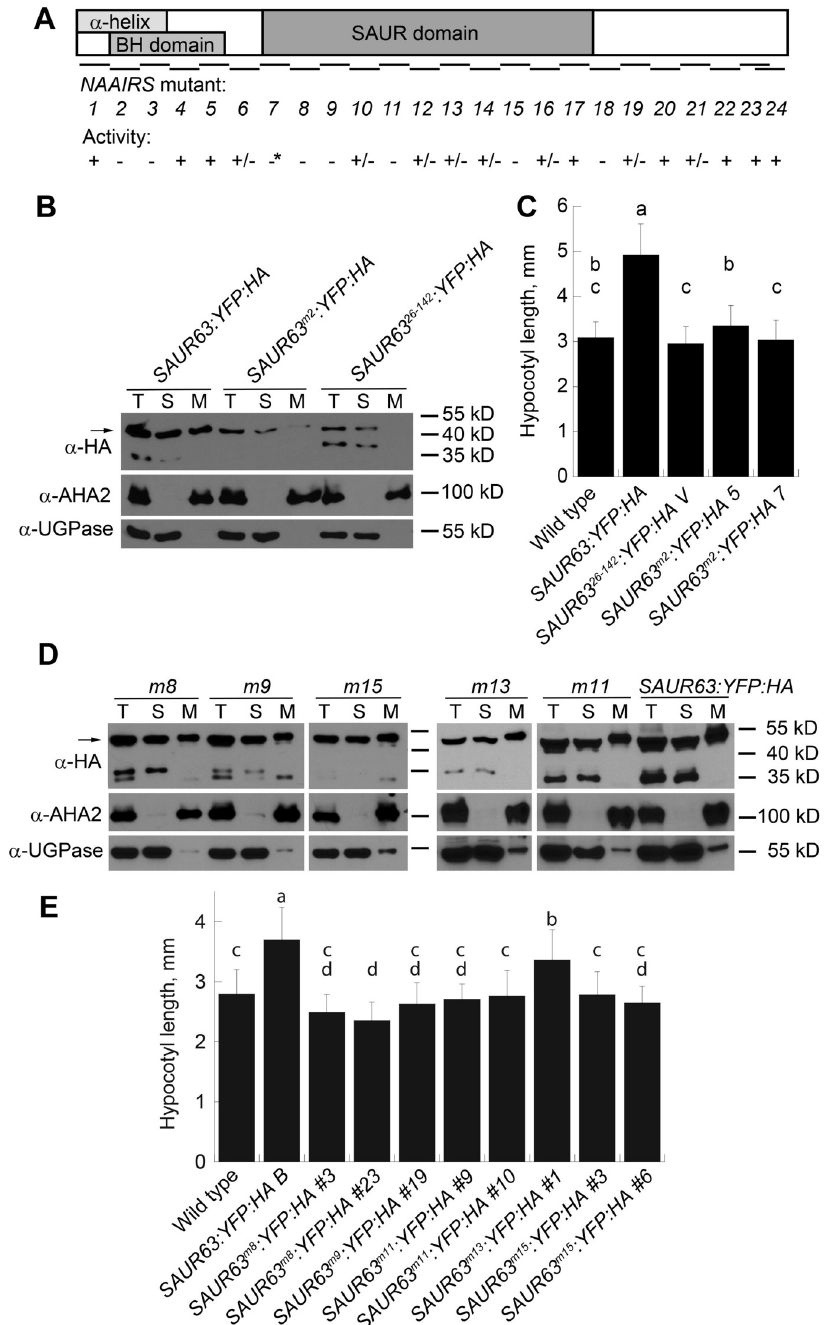
Fig 7. Effects of mutations on SAUR63 properties. A) Diagram of SAUR63 indicating predicted structural features, locations of NAAIRS mutations m1 - m24 , and whether SAUR63:CerFP:HA and/or SAUR63YFP:HA fusion proteins with each mutation retained function, based on their ability to confer either tortuous root growth or increased hypocotyl elongation in Figs 7C and 7E and S11 and S1 Table. +, caused phenotypes in all experiments; -, failed to cause phenotypes in all experiments; +/- caused phenotypes in at least one experiment; � , no fusion protein detected. B,D) Fusion proteins in stable P : SAUR63 NAAIRS : YFP : HA lines, detected by western blots in total (T), soluble (S) and 35S microsomal (M) protein fractions. α -HA detects SAUR63:YFP:HA fusion protein variants; α -AHA2 detects a membrane protein; α -UGPase detects soluble proteins. In D, P : SAUR63 NAAIRS : YFP : HA line names are abbreviated 35S by the mutation name ( m8 etc.). C,E) Hypocotyl lengths of stable lines of seedlings grown for 4d in short days. Graph shows means ± s.d. Letters indicate statistical classes based on Tukey’s Honestly Significant Difference test. n, from left to right: panel C: 55, 30, 34, 31, 36; panel E: 17, 24, 29, 21, 24, 27, 29, 24, 29,